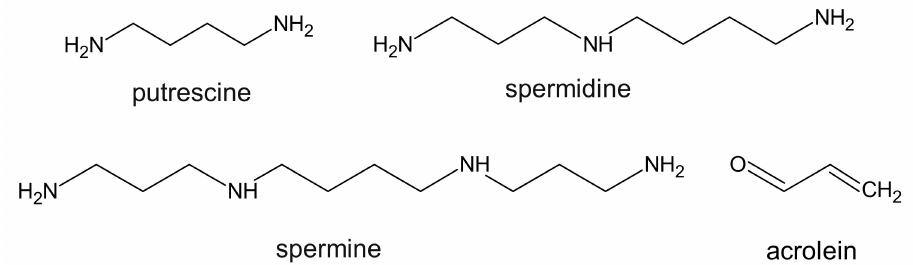
Figure 5. Chemical structure of polyamines and their derivative, classified as protein-binding uremic